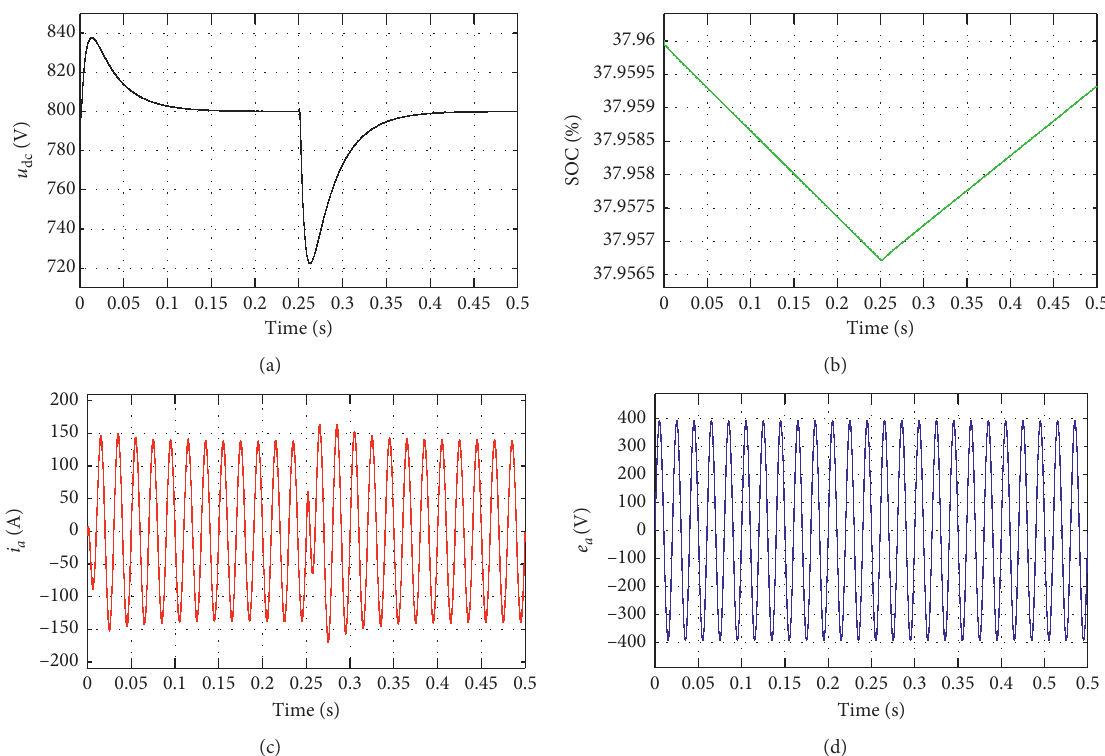
Figure 14: The waveforms of V2G system in different conditions. (a) The DC bus voltage of bidirectional AC/DC converter. (b) The state of charge (SOC) of battery. (c) The gird-connected current curve of phase A. (d) The grid voltage curve of phase A.